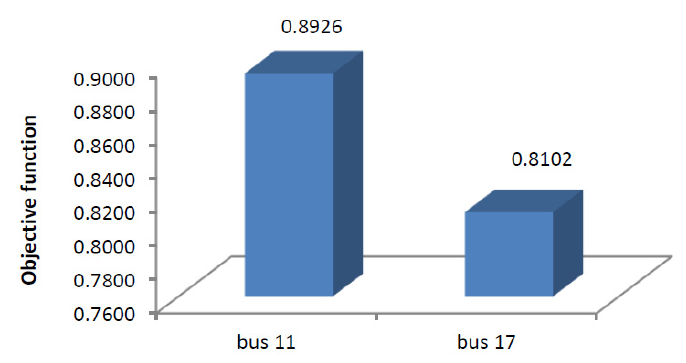
Figure 6. Objective function (OF) to determine the third DER location. Table 1. Summary of the results of the highest APF, TVS, and OF calculations to determine the DER location.